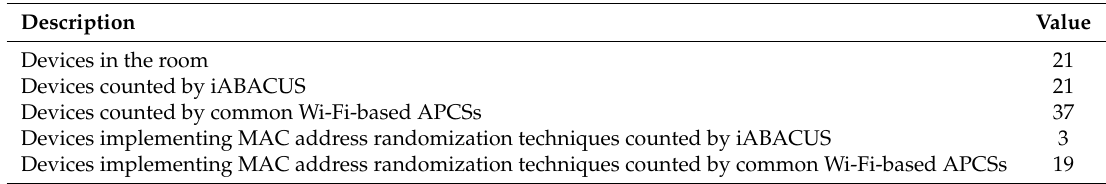
Table 4. Results for the accuracy evaluation of the de-randomization